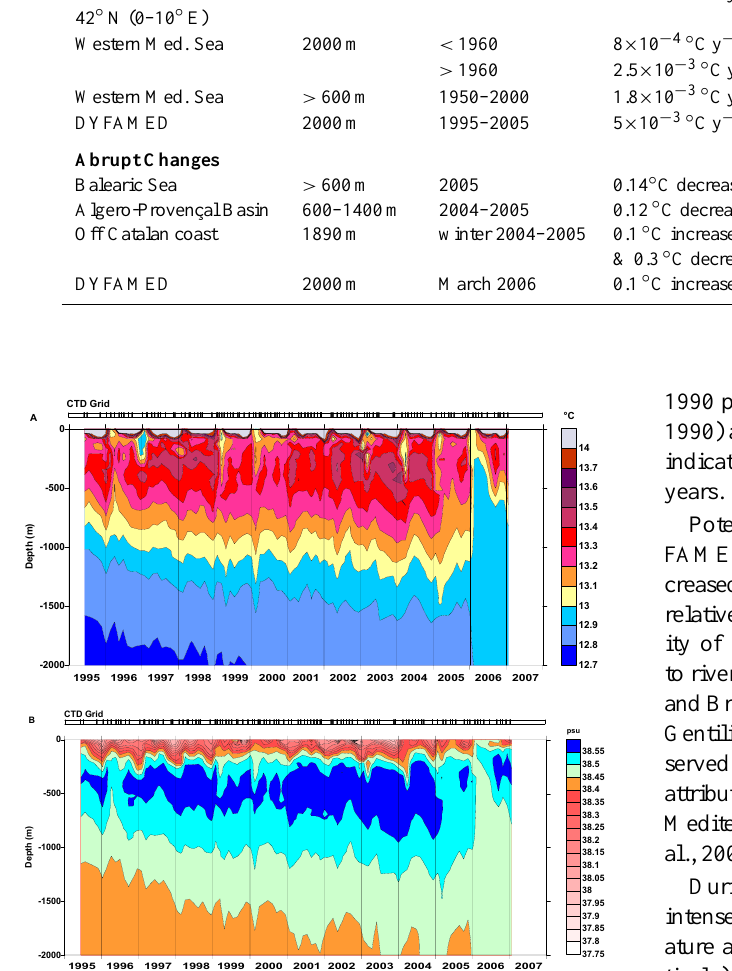
Fig. 3. Contour plots of potential temperature ( A , ◦ C) and salin- ity ( B , psu) at DYFAMED site, drawn using Surfer program and kriging method. The near-monthly sampling timetable is indicated above the contour plots (CTD